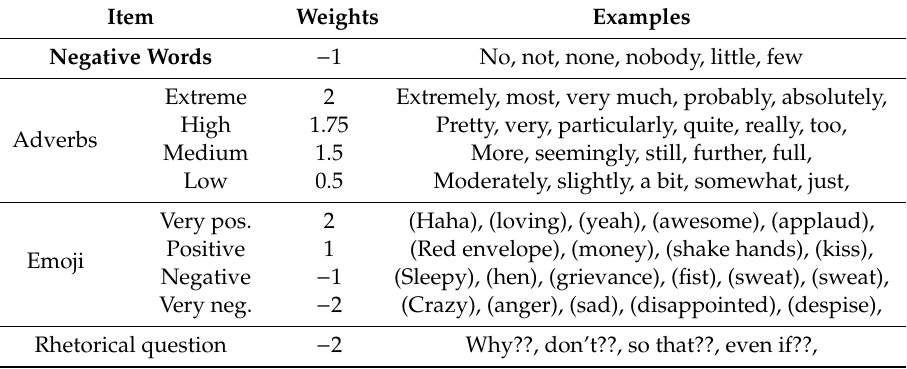
Table 1. Emotional text